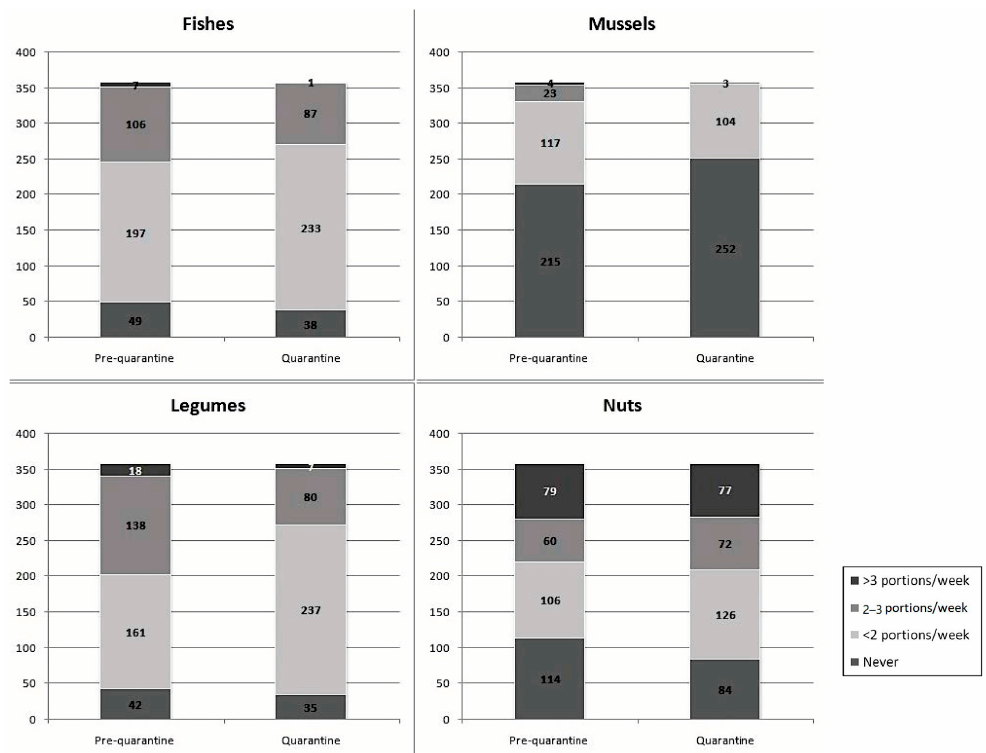
Figure 4. Changes in fishes, mussels, legumes and nuts intake during quarantine (portions/week). Table 2. Percentage of total energy derived from the main diet components of the interviewed subjects. Diet Components